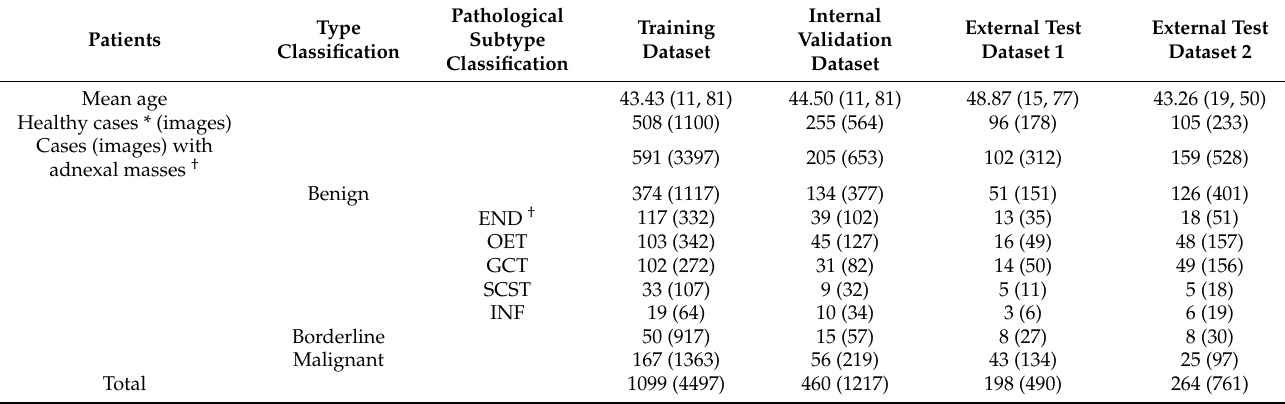
Table 1. Baseline characteristics of datasets in the